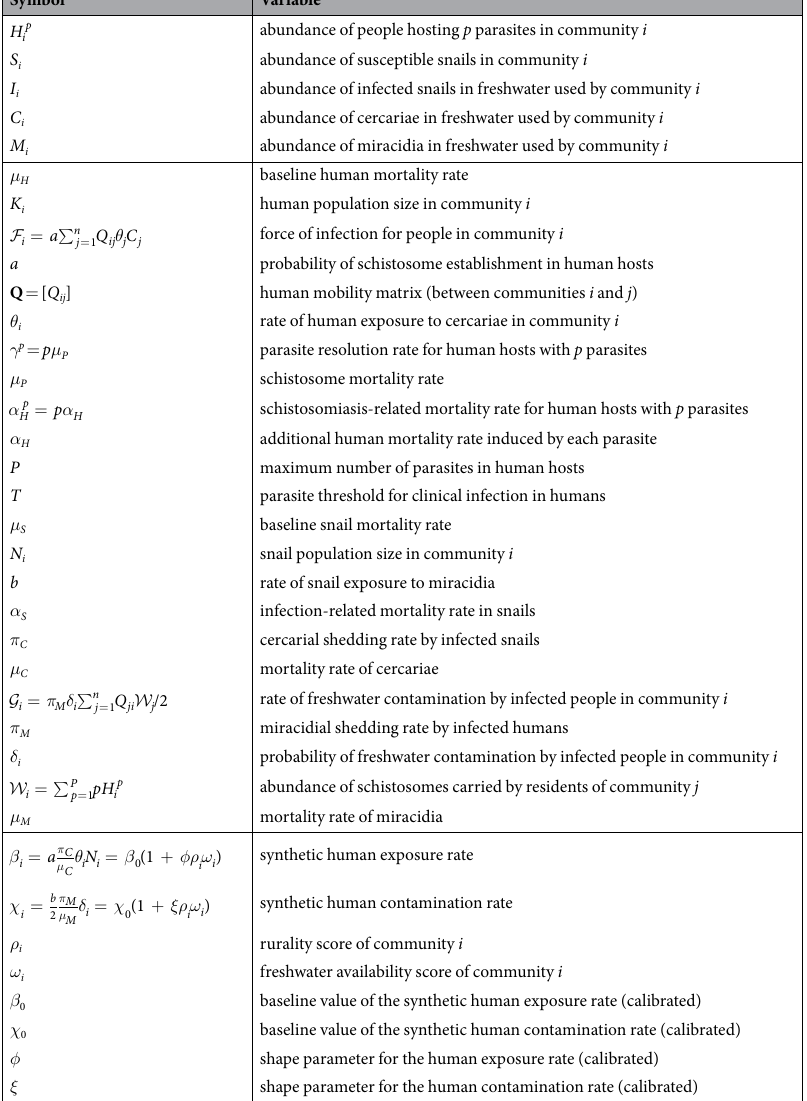
telecommunication provider (with a customer base of more than 9 million people). The model is parameterized with georeferenced data on population abundance, socioeconomic conditions and freshwater distribution, and calibrated against the most up-to-date regional estimates of urogenital schistosomiasis prevalence currently avail- able at the Senegalese Ministry of Health (Figs 1b–e and S2). Specific aim of this work is to assess the impact of environmental conditions and human mobility on schistosomiasis transmission from local to regional scales. To that end, we compare the performances of four model set-ups characterized by different assumptions regarding the spatial grain of environmental heterogeneity and the inclusion of human mobility ( Methods ). We also illus- trate how the analysis of local heterogeneities in disease transmission can help guide resource allocation in the fight against the disease, with the overarching goal of showcasing how mathematical modeling can be used for societal development, namely by assisting decision makers in the fight against a poverty-reinforcing infection like schistosomiasis.